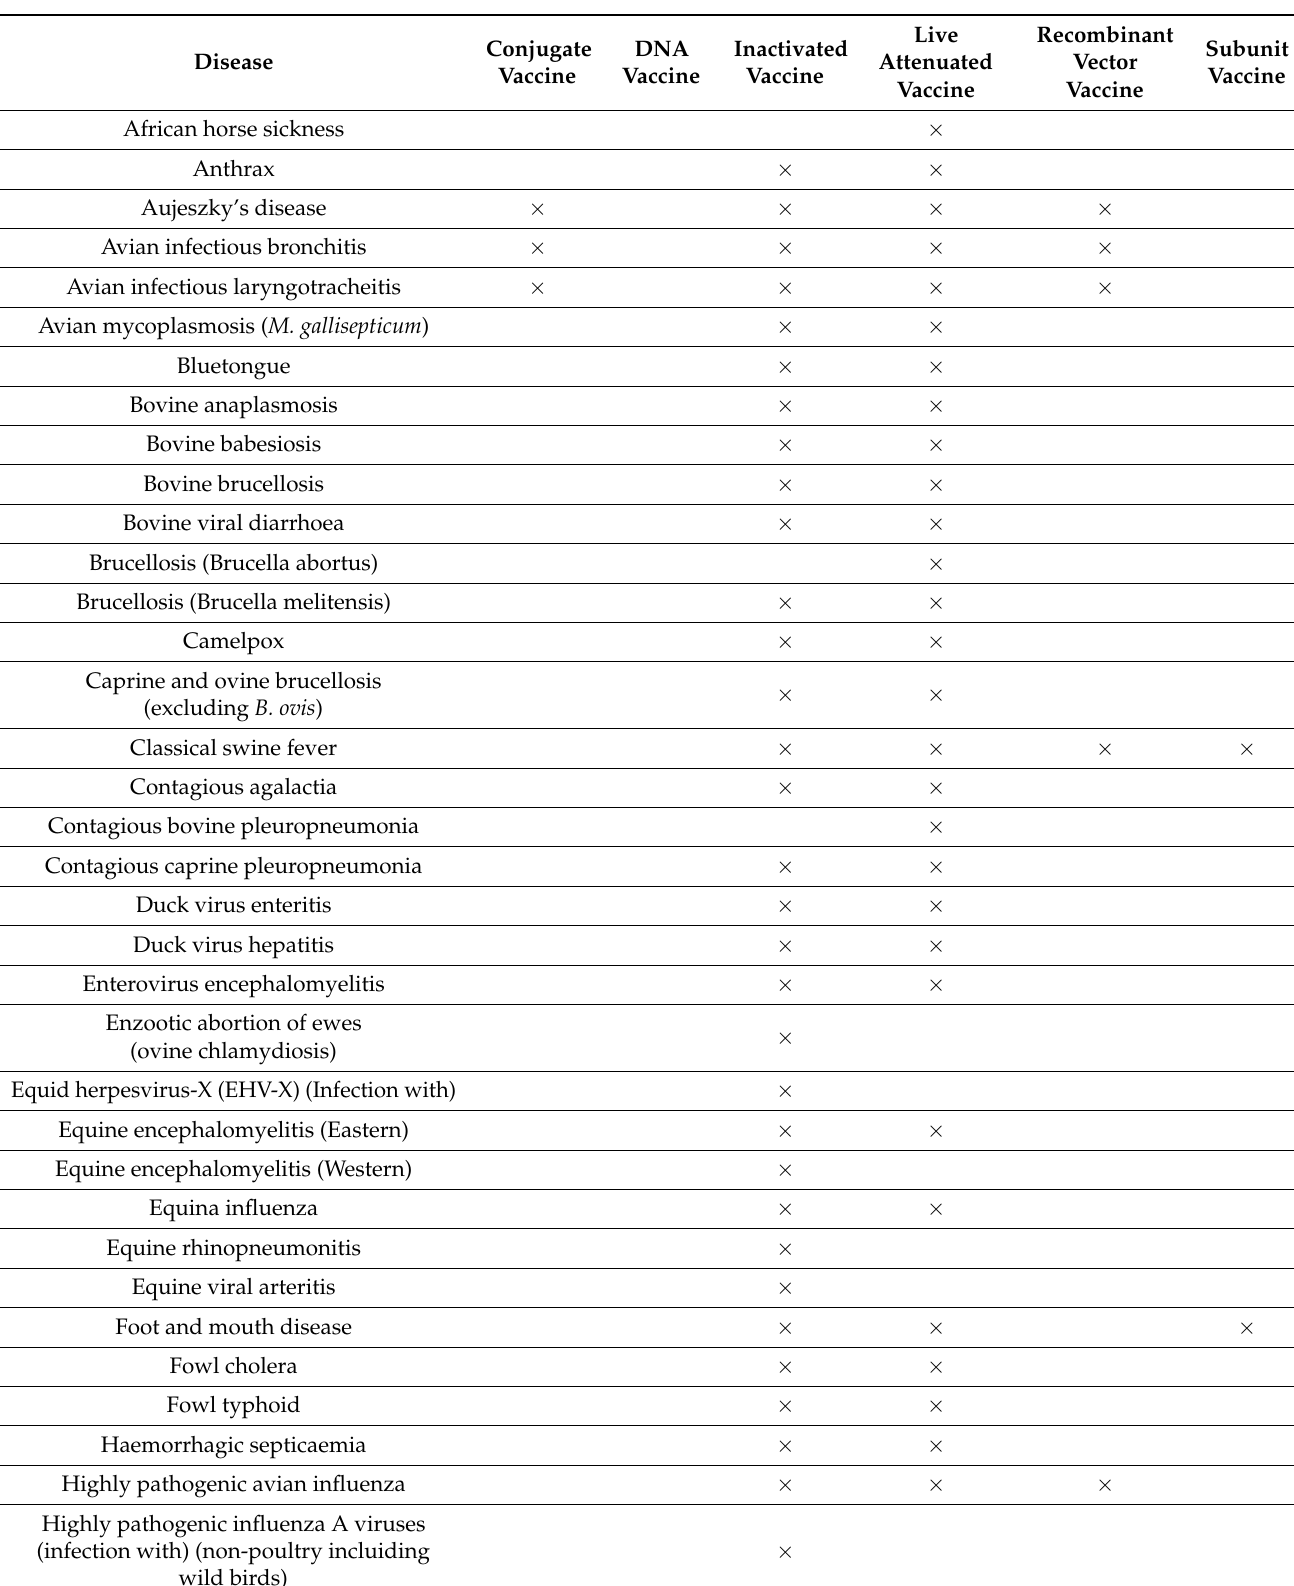
Table A2. Information on animal vaccines production worldwide as submitted to the OIE by Member Countries. It is important to consider that not all the available vaccines on the market are reported as only the laboratories under national veterinary services are requested to provide information on the vaccines produced (e.g., vaccines produced by private industries might not be reported to the OIE). Conjugate DNA Disease Vaccine Vaccine